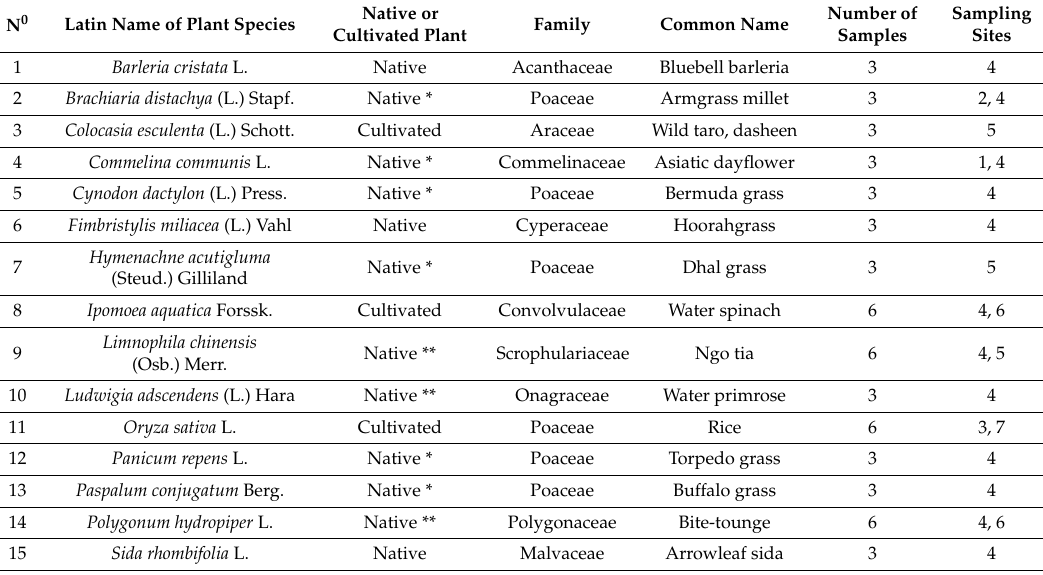
Table 1. Plant species collected at the Dong Mai lead recycling